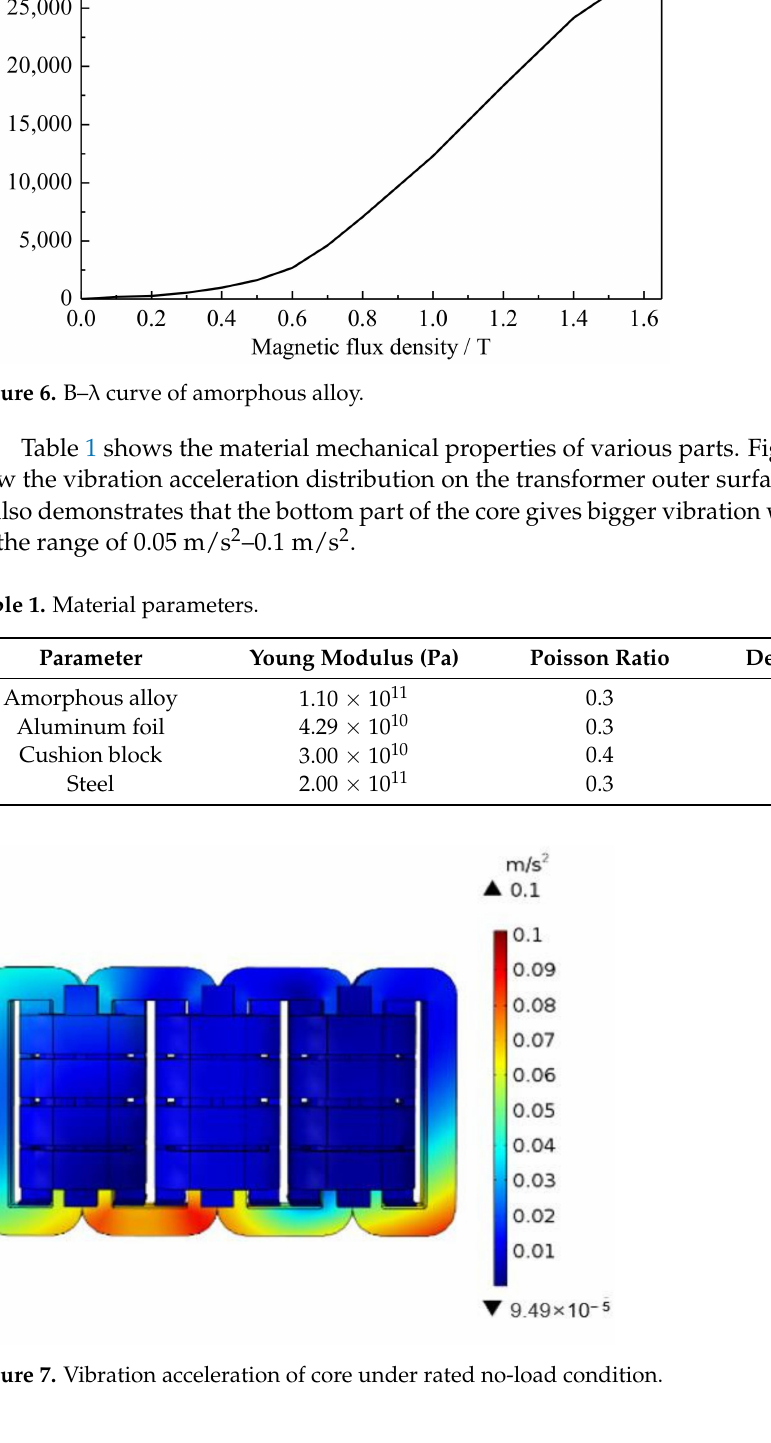
Figure 6. In practical operation, the amorphous alloy core is in a suspension state. Due to